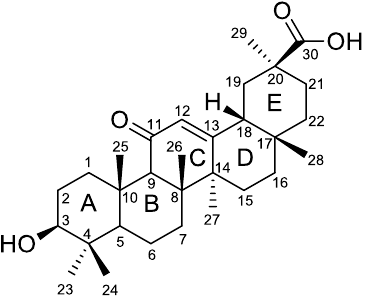
Figure 1. Chemical structure of glycyrrhetinic acid 1 .